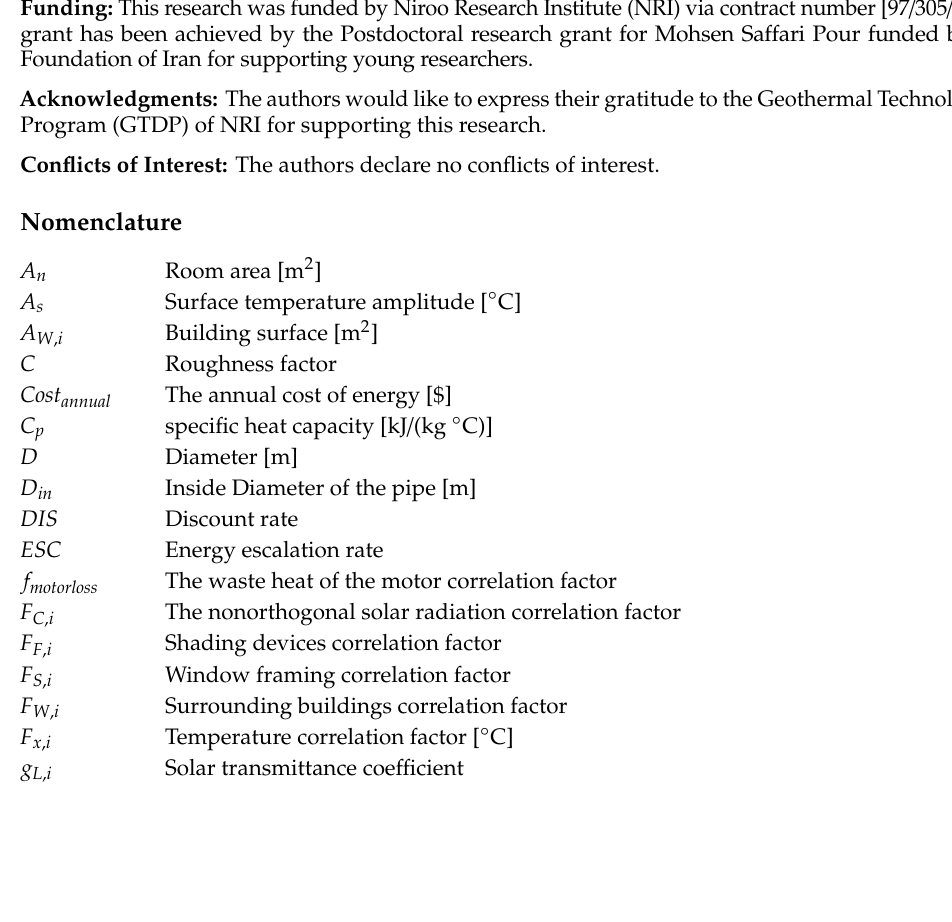
Table S1: Thermophysical properties of the materials used in